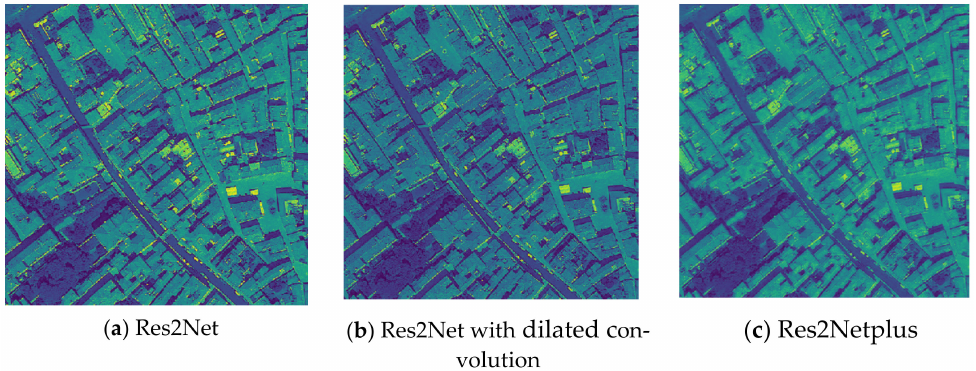
Figure 3. Comparison of improved Res2Net: ( a ) the result of Res2Net; ( b ) the result of Res2Net with dilated convolution; ( c ) the result of Res2Netplus with our